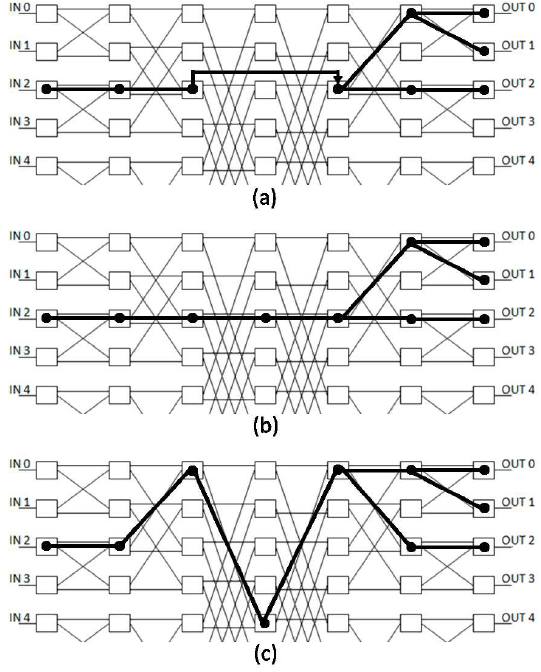
Figure 7. Three different multi-fanout paths connecting IN 2 to OUT 0 , OUT 1 , and OUT 2 in order of cost: with bypass enhancement ( a ), with the as-straight-as-possible policy ( b ), and using diagonal wires ( c